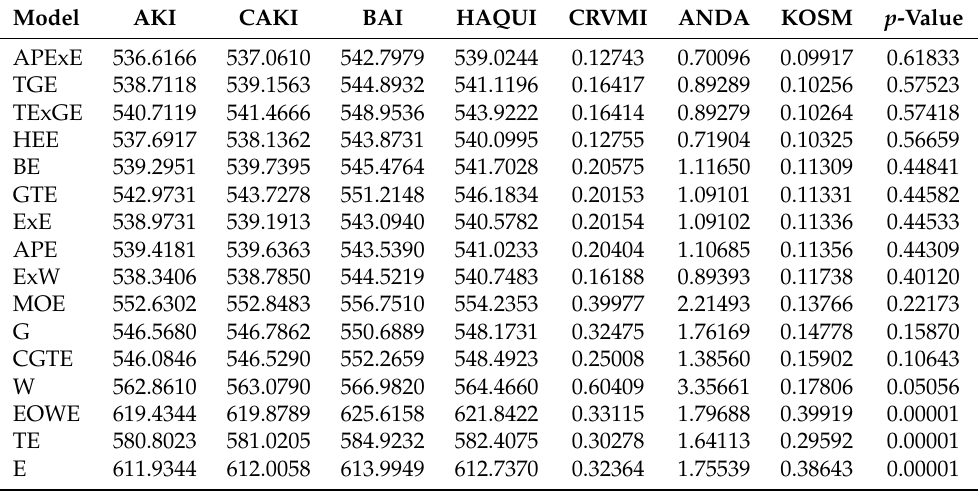
Table 5. Discrimination measures of the APExE model and other competing